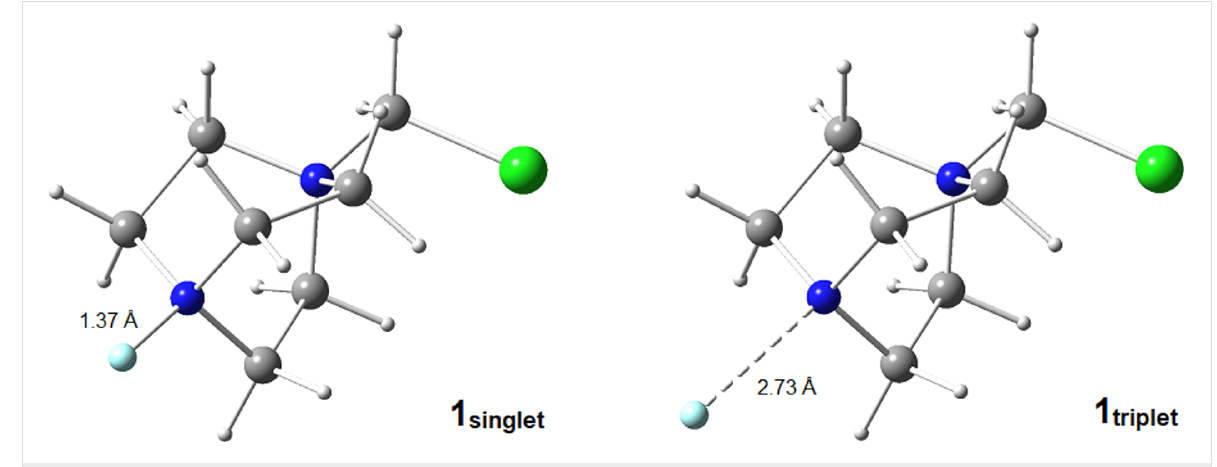
Figure 9: 3D structures of the singlet ground and triplet excited states of Selectfluor ® .